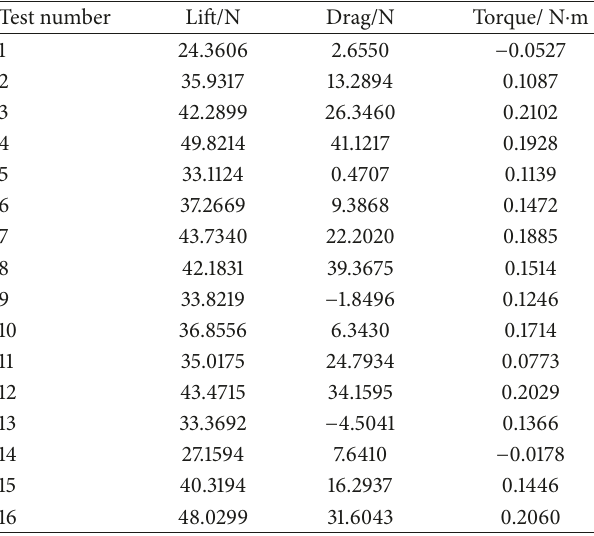
Table 4: 𝐿 16 (4 3 ) test results of